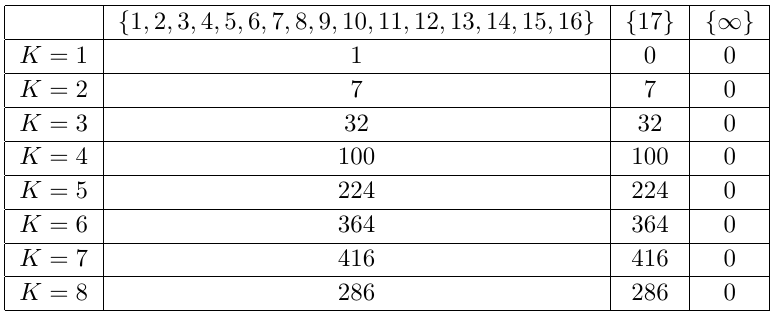
Table 14 . Number of Bethe roots for decomposed BAE with M = 17.